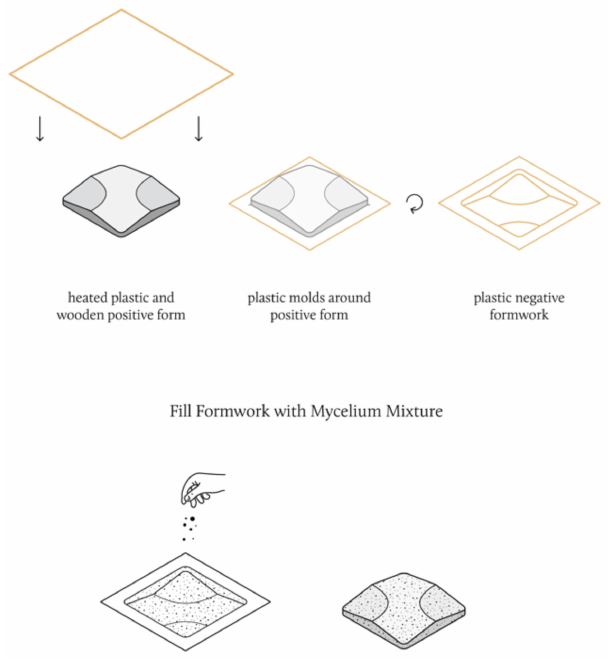
Figure 5. Acoustic Panel Fabrication